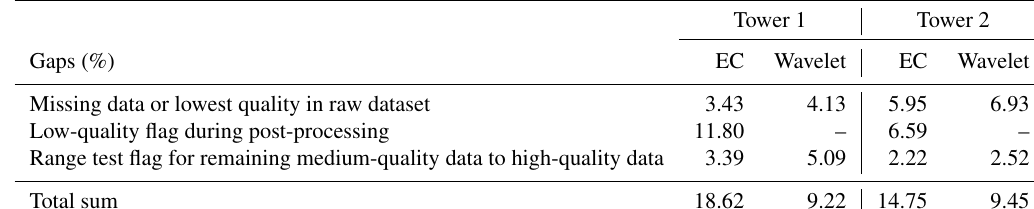
Table 2. Gap fraction within the dataset used for this study, separated by flux processing method and tower position.